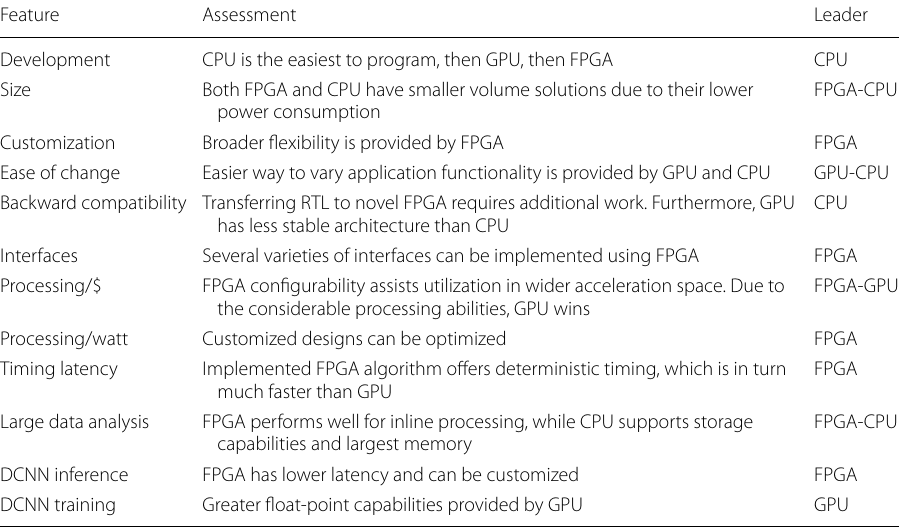
Table 3 A comparison between different aspects related to the devices